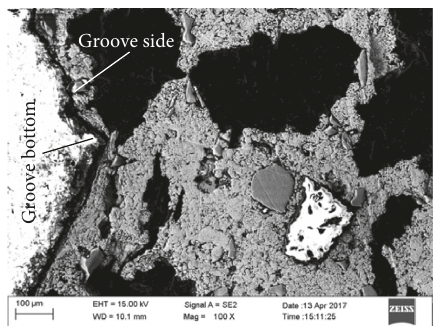
Figure 10: Microstructure of the groove surface